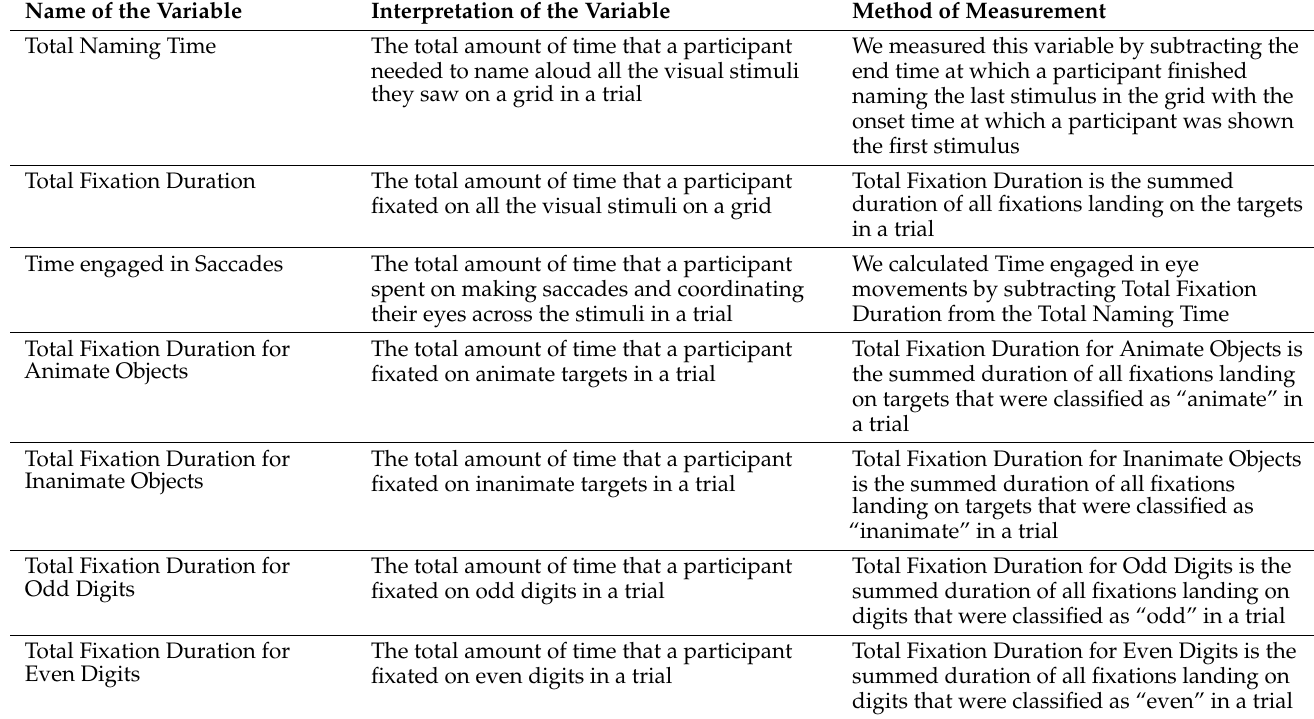
Table 2. Variables in the study, their interpretation and method of measurement (all in seconds).